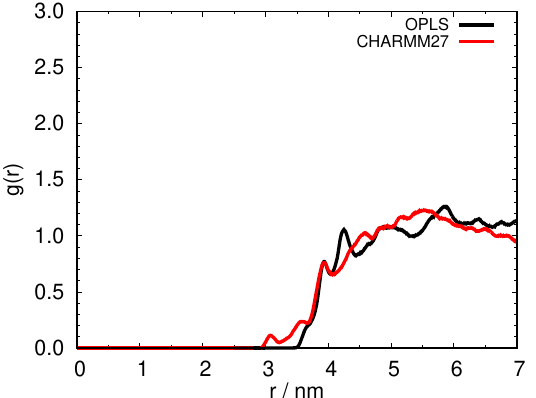
Figure 8. Protein–protein COM pair distribution function comparison between OPLS (black) and CHARMM27 (red) force field for 93 mg mL − 1 aqueous HEWL solution at 267 K with added 0.3 M